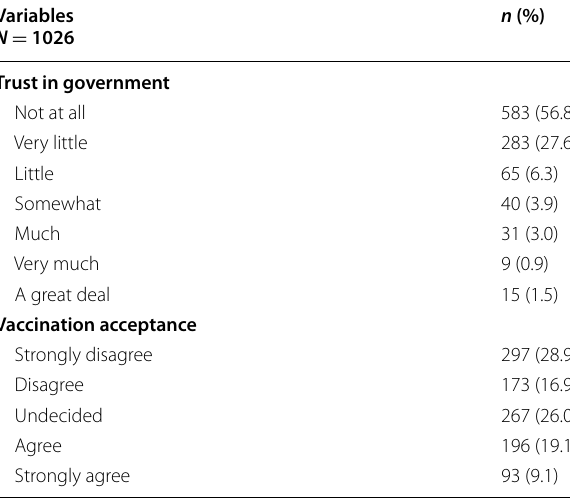
Table 2 Levels of trust in government and acceptance